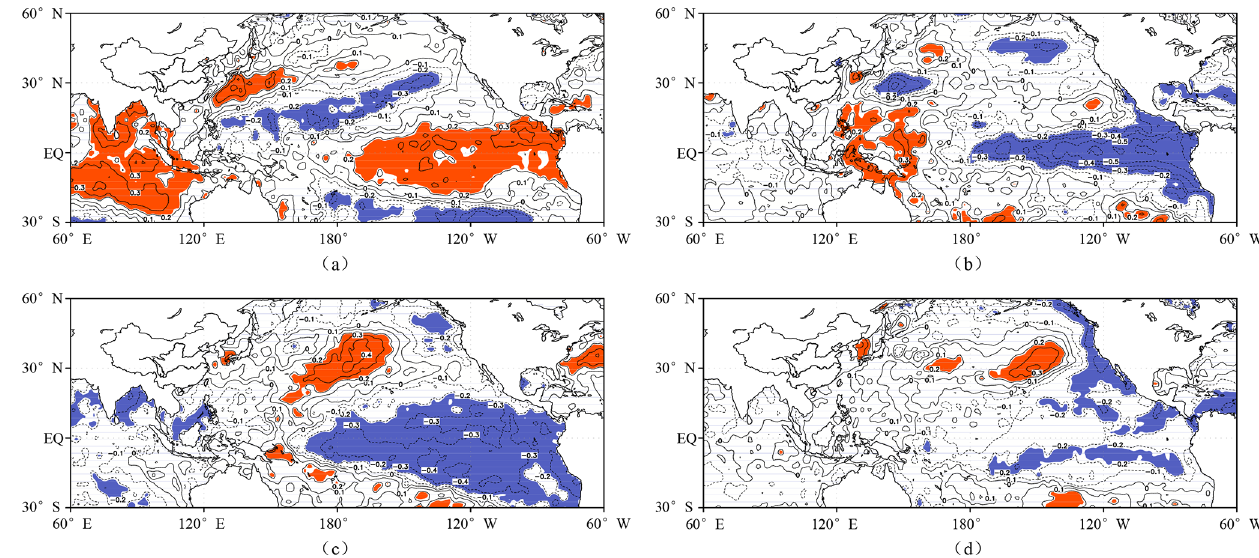
Figure 4. The correlation between precipitation in spring (a) , summer (b) , autumn (c) and winter (d) in the Yellow River Basin and the corresponding SST. (The shadow indicated the area passing the significance test at 0.1